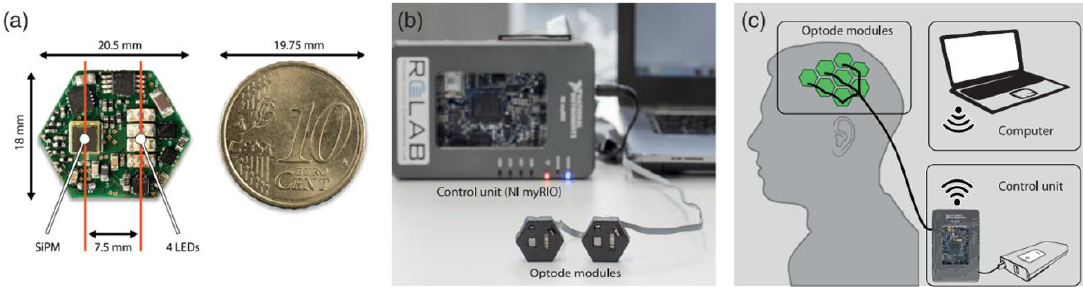
Figure 9. A compact fNIRS instrument. ( a ) The PCB next to a 10-cent euro coin. ( b ) Picture of the fNIRS system with two optode modules. ( c ) Conceptual sketch illustrating the arrangement of the system. Reproduced from reference [40].